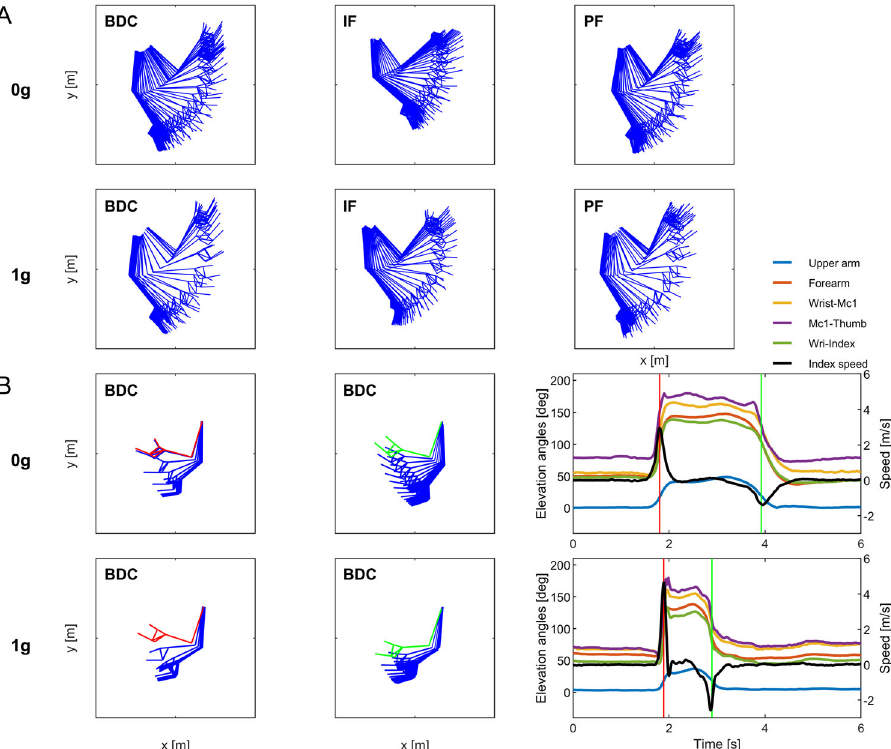
Fig. 7 Arm kinematics. A Six representative trials of participant S9. Left to right, stick diagrams (every 50 ms) of trials performed pre- fl ight, in- fl ight, and post- fl ight, for imaginary 0 g (top) and 1 g (bottom). B Two representative trials of participant S8 (left-handed). Left: stick diagrams (every 50 ms) prior to throw, and after catch. Red and green sticks correspond to throw and catch times; the other sticks were sampled backward or forward relative to throw and catch, respectively. Right: time course of the elevation angles of the upper arm, forearm, fi rst metacarpus, thumb, index, and “ vertical ” component of index velocity. Red and green vertical lines correspond to throw and catch times.